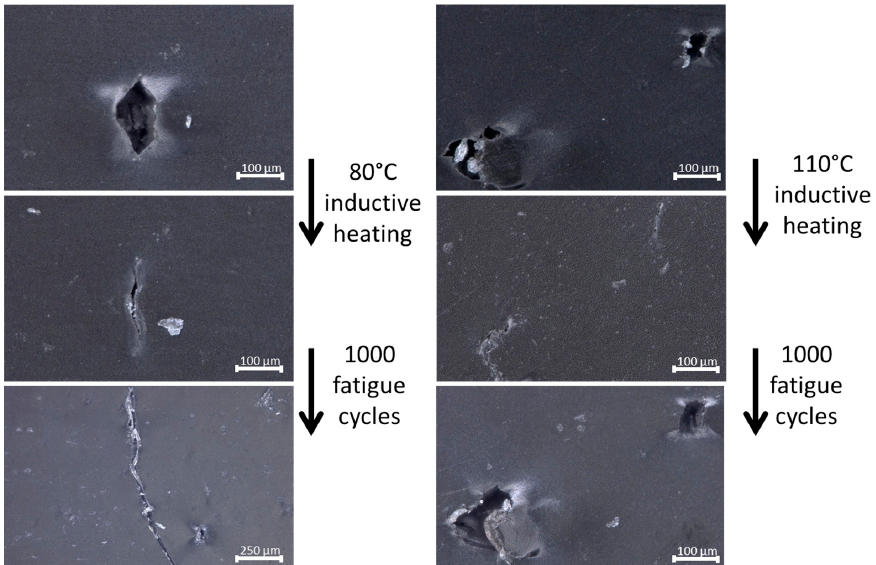
Figure 7. OM images showing the difference between crack closure and crack sealing which is achieved by inductive at different temperatures: ( left ) the crack closure at 80 °C and the further crack propagation upon a second treatment of 1000 fatigue cycles; and ( right ) a series of cracks that are sealed at 110 °C and reopened upon a second fatigue treatment of 1000 fatigue cycles.